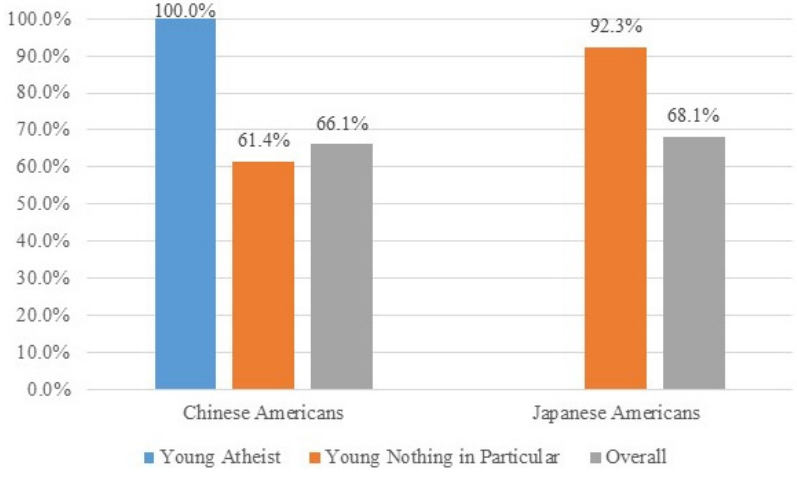
Figure 20. Supports legal abortion.